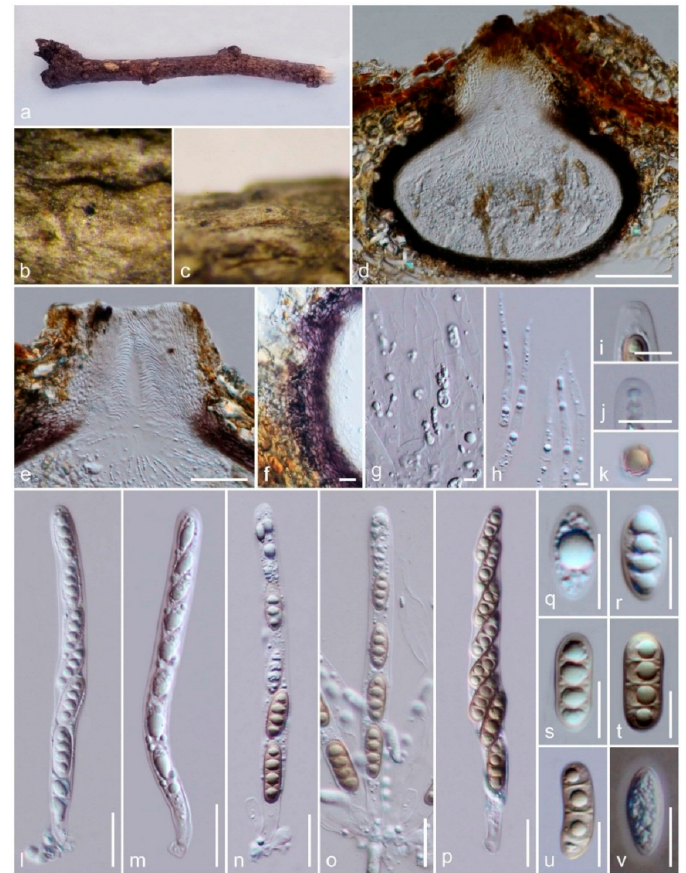
Figure 5. Sexual morph of Amphisphaeria curvaticonidia (MFLU18-0789, holotype). ( a – c ) Ascomata on the substrate; ( d ) vertical section of ascoma; ( e ) ostiole; ( f ) peridium; ( g , h ) paraphyses; ( i ) apical ring (in water); ( j ) apical ring bluing in Melzer’s reagent; ( k ) ascospore (top view); ( l – p ) asci; ( q – v ) ascospores (v in Indian Ink). Scale bars are set at, ( d ) 100 μ m; ( e ) 50 μ m; ( f , l – p ) 20 μ m; ( i , j , q – v ) 10 μ m; ( g , h , k ) 5 μ m.